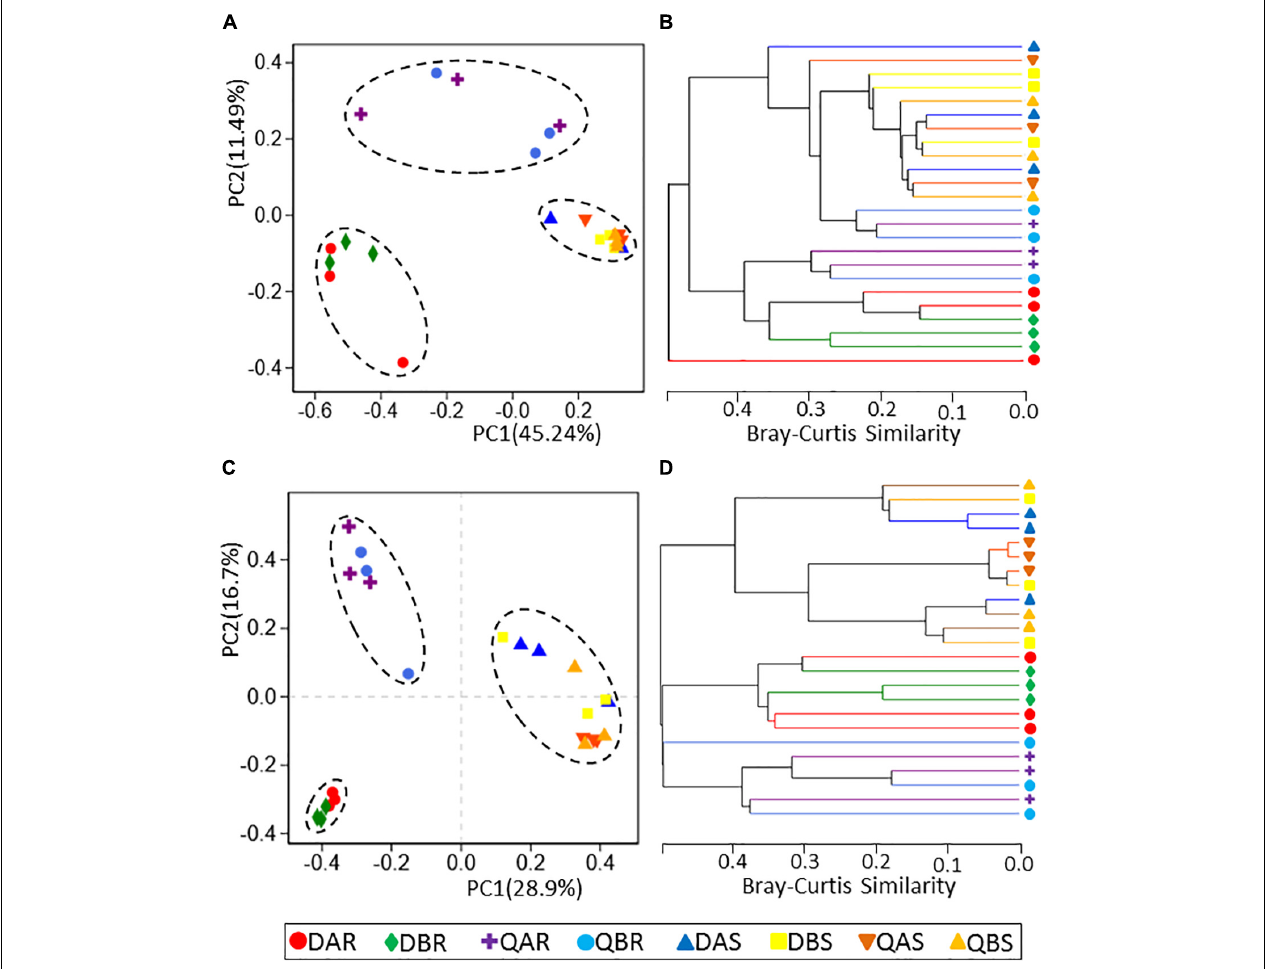
FIGURE 3 | Principal co-ordinates analysis (PCoA) and hierarchical clustering of bacterial and fungal communities. (A) PCoA for the bacterial communities. (B) Hierarchical clustering for the bacterial communities. (C) PCoA for the fungal communities. (D) Hierarchical clustering for the fungal communities. PCoA of samples based on rarefaction to the minimum sample sequence number. Operational taxonomic units (OTUs) were defined at a 97% sequence similarity. Hierarchical clustering (group average linkage) of the samples based on Bray–Curtis dissimilarity. PCoA and hierarchical clusters analysis were based on three biological